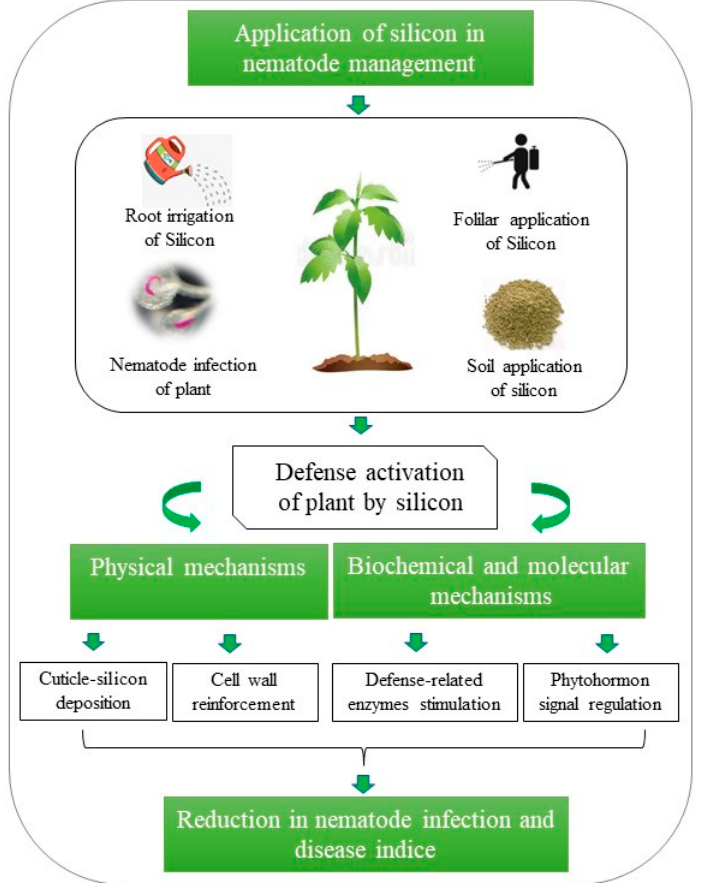
Figure 1. Silicon mediated plant defense against nematodes and the interaction mechanisms of plant-nematodes. Briefly, Si-containing compounds were used on plant roots or leaves to control a wide range of nematodes. In response to nematode attack on the plants, various defense mecha- nisms are activated by Si application. These defense mechanisms may involve physical, biochemical, and molecular defense. Physical mechanism embeds deposition of Si below the cuticle or reinforce- ment of cellwall, which hinders the entry of nematodes. Biochemical defense may involve stimula- tion of defense related enzymes that reduces the damage of nematodes. Molecular defense modu- lates defense-related genes that improves plant resistance against nematodes. Additionally, silicon may be deposited in the subcuticular layer and intercellular spaces [60]. This alters the anatomy and increases the silicification and accumulation of lignin and phenolic compounds in the lesions, enhancing the physical barrier and pre- venting nematodes’ penetration [61]. Secondly, the presence of silicon in a plant can im- prove the activity of plant defence enzymes and the regulation of JA, SA, and ET